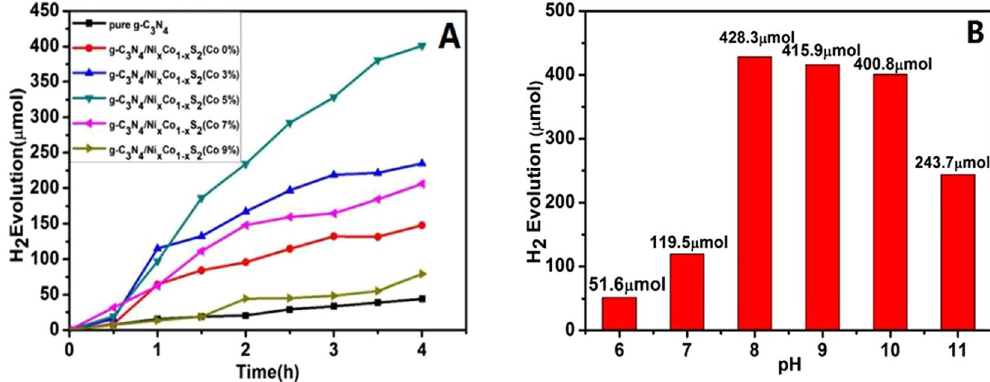
Figure 5. ( A) Hydrogen evolution over Eosin Y-sensitized catalyst (10 mg) in 15% TEOA aqueous solution (pH = 10) and ( B ). The influence of pH on photocatalytic activity over the g-C 3 N 4 /Ni x Co 1 − x S 2 (Co content 5% and reaction time: 4 h).